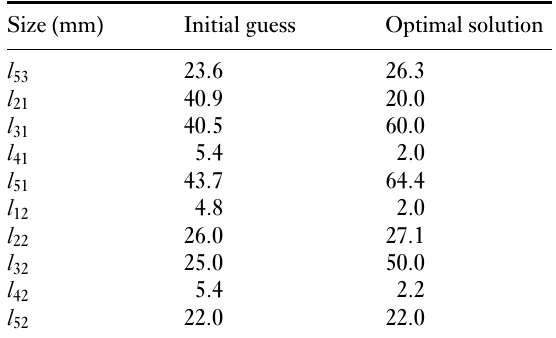
Figure 16 Evolution of the design parameters γ 2 , γ (cid:3) Table 2 Design parameters of the optimal design solution of Figure